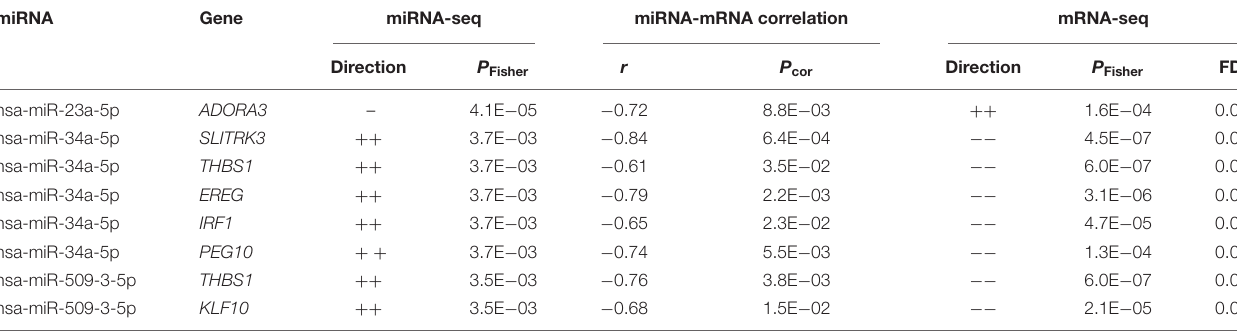
TABLE 3 | List of AA-miRNA and Downstream Direct Targets. miRNA Gene miRNA-mRNA correlation